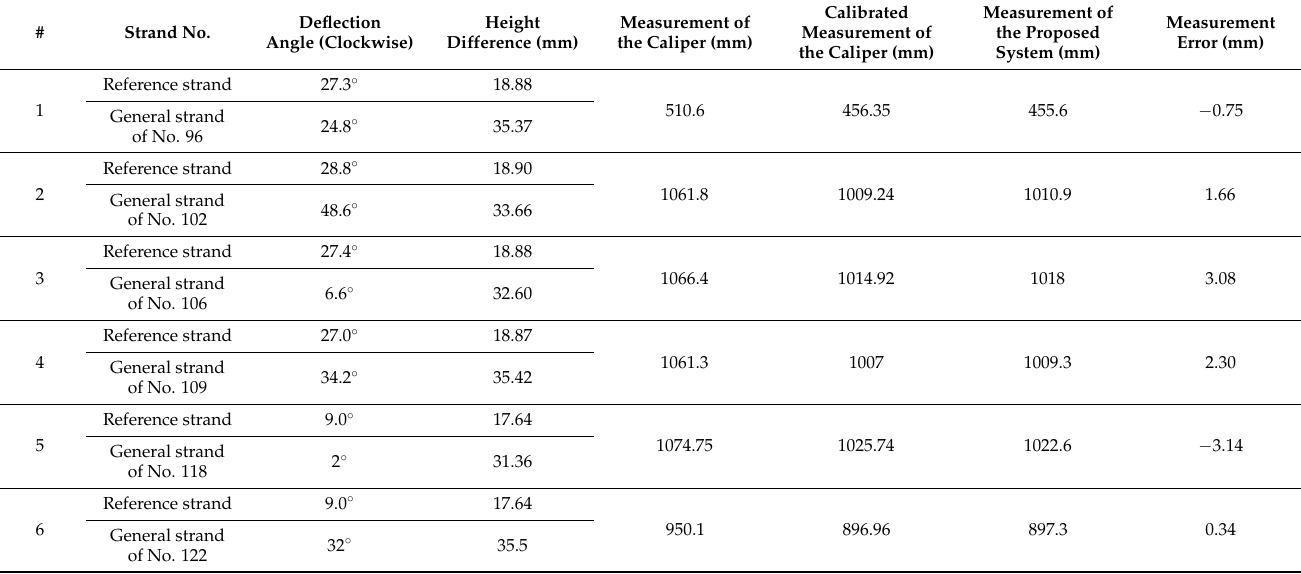
Table 6. Measurement results of the caliper vs. the proposed measuring